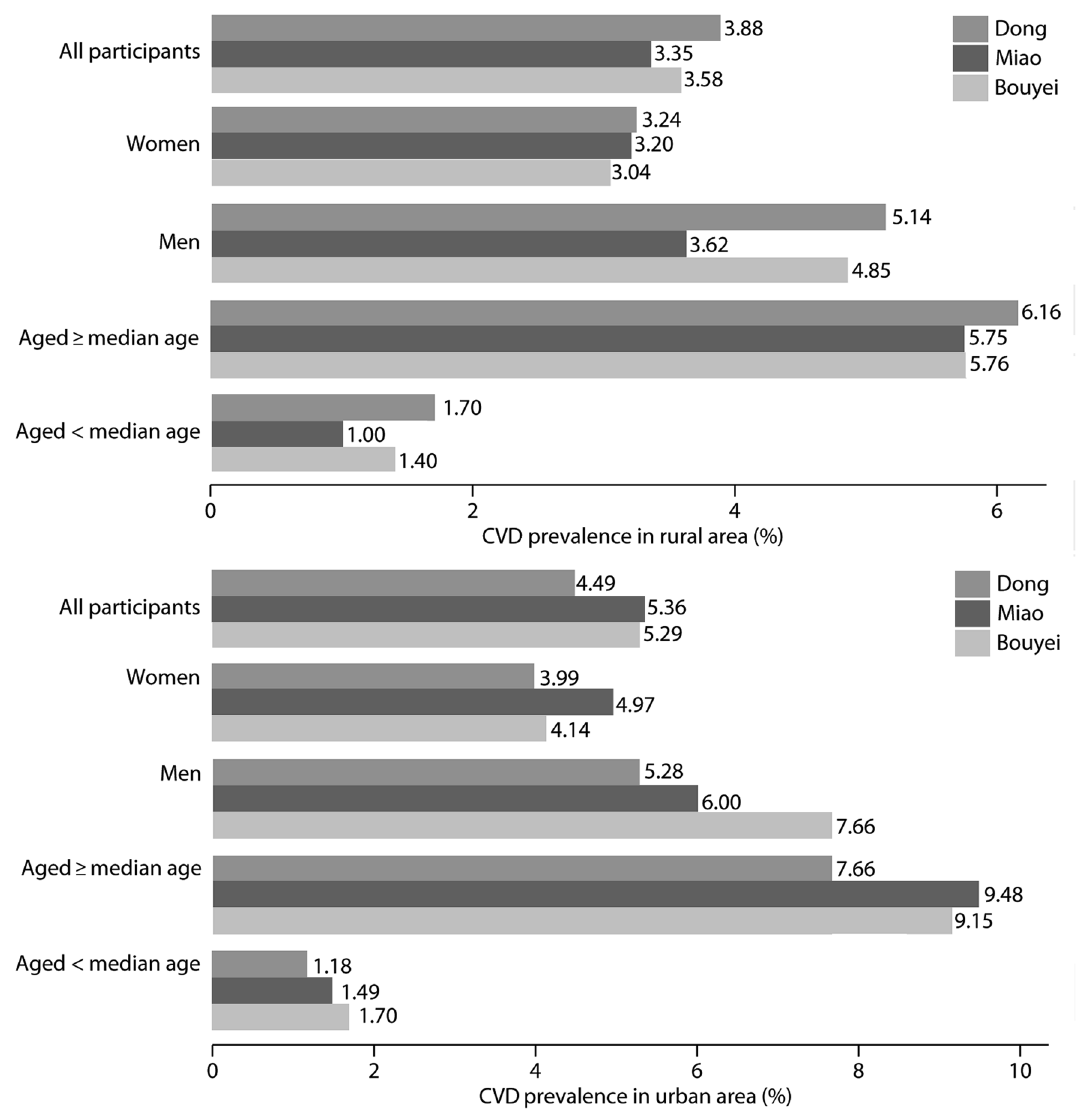
Figure 1. Prevalence of cardiovascular disease, coronary heart disease, and stroke in rural and urban areas. CHD coronary heart disease; CVD cardiovascular